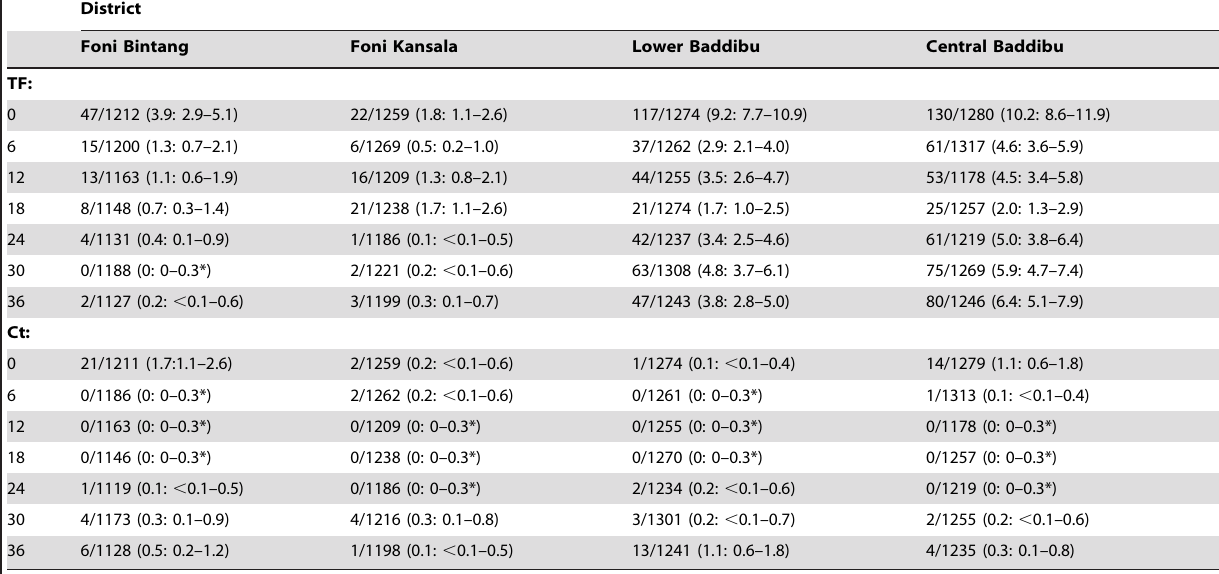
Table 3. District-level prevalence of trachoma outcomes in children 0–5.